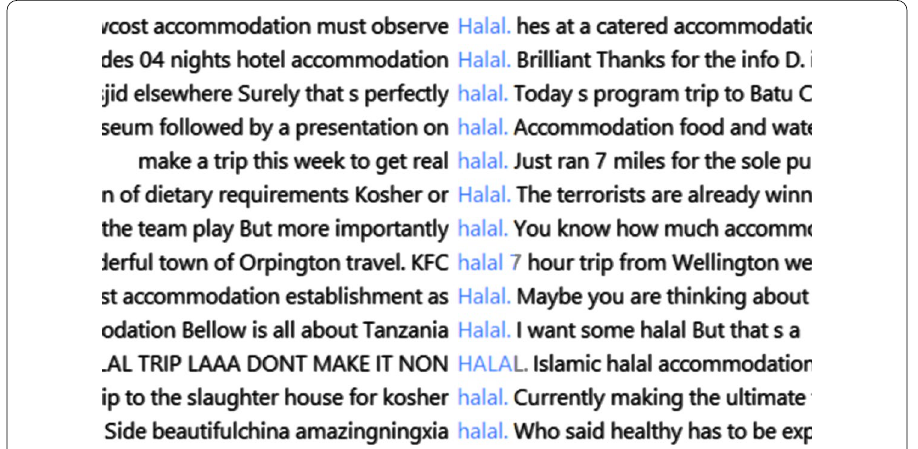
Fig. 3 Concordance graph for the word “halal” in halal tourism tweets